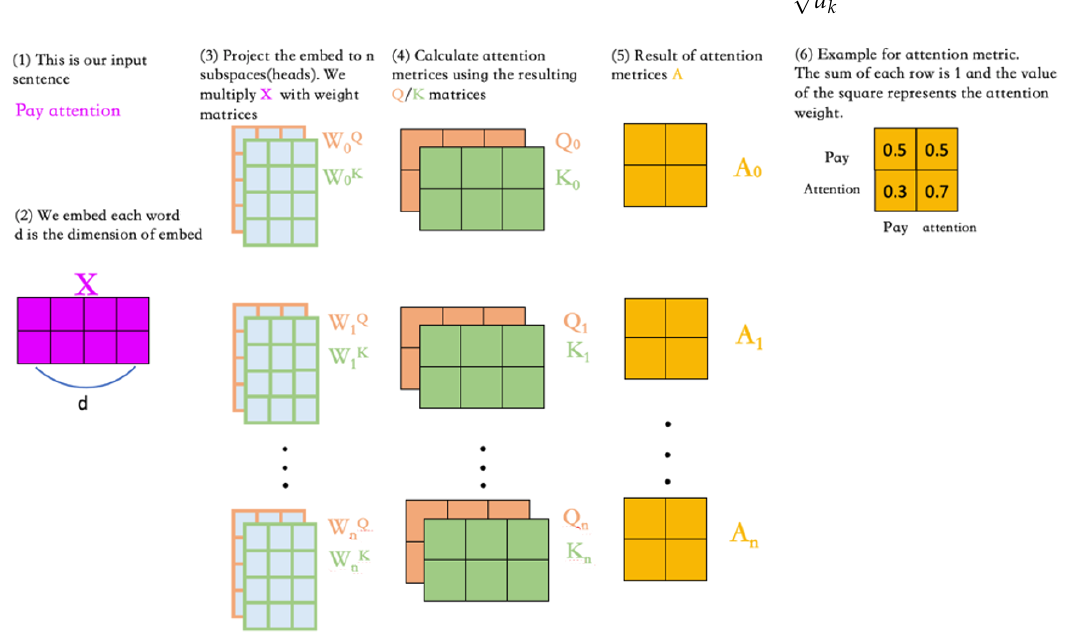
Figure 4. Illustration of the attention matrix calculation of “pay attention” at a layer. The attention matrix of this example is at step